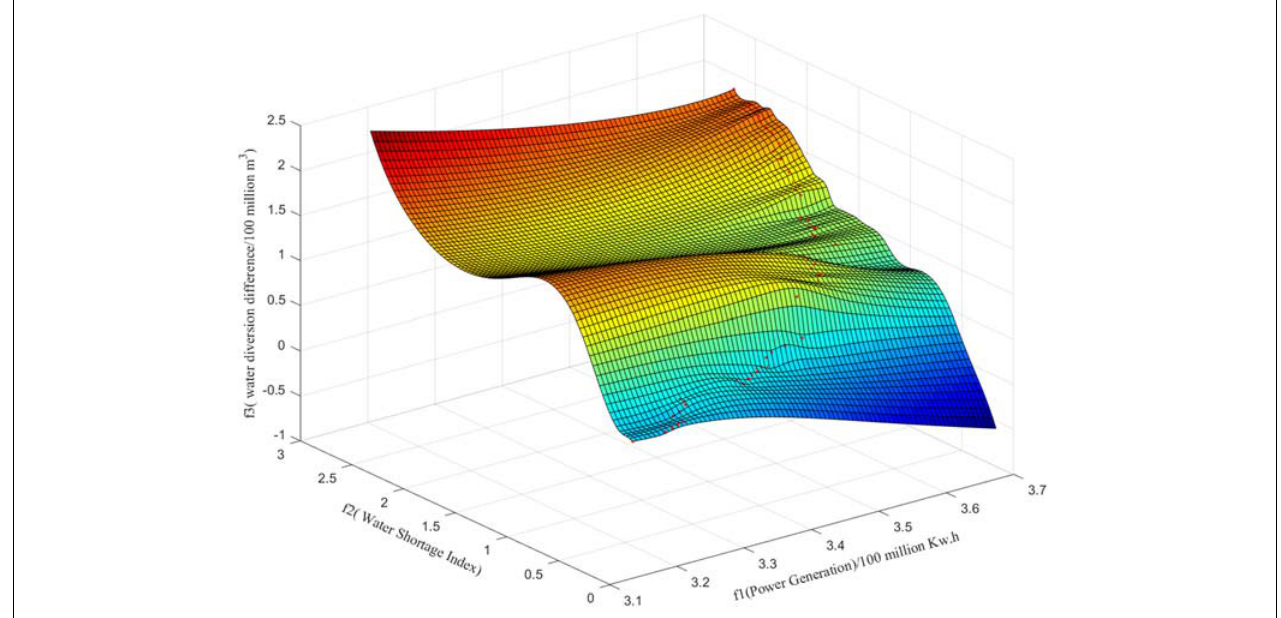
FIGURE 5 | Three-dimensional distribution diagram of Pareto solution